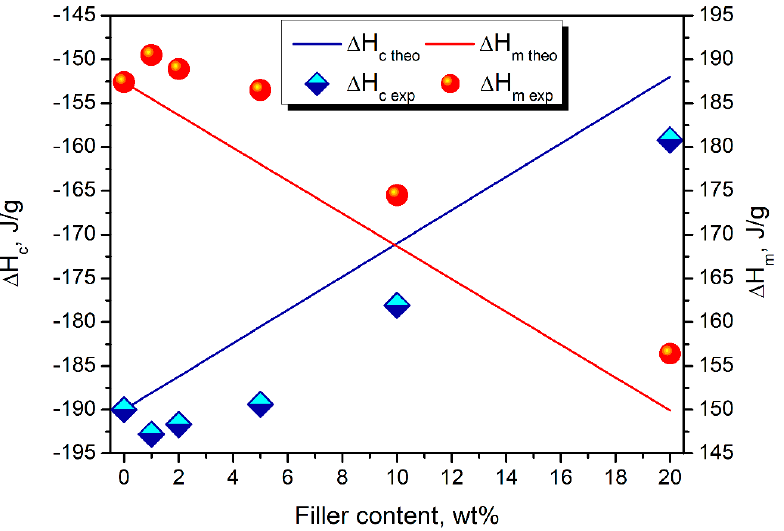
Figure 6. The impact of filler content on the crystallization and melting enthalpies of prepared composites.